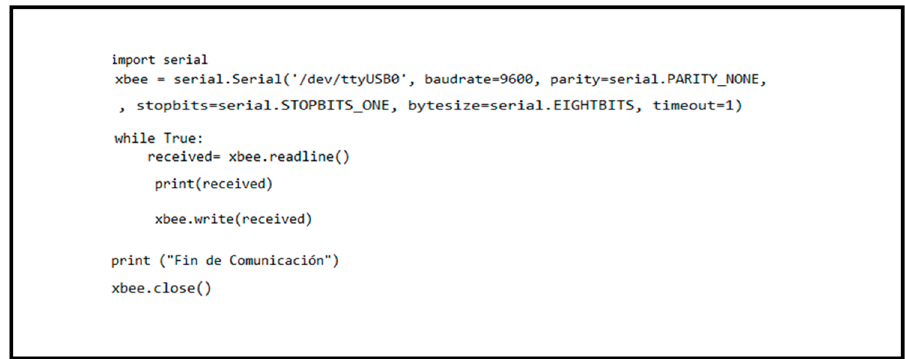
Figure A1. Raspberry Pi programming for XBee devices with ZigBee protocol.